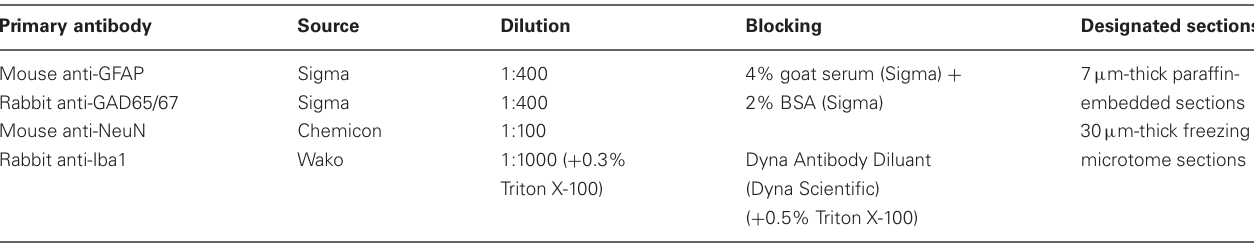
Table 3 | Dilution, blocking, and designated sections for all primary